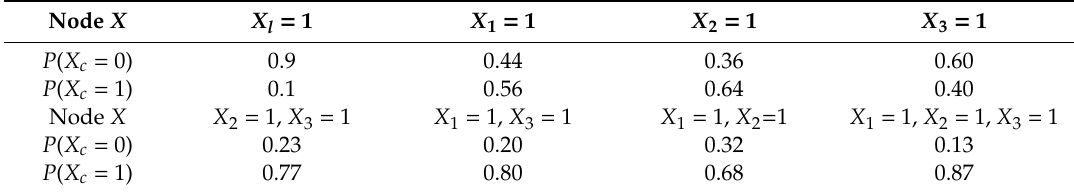
Table 4. Conditional probability parameters of Node “Overtopping” ( × 10 − 4 ).